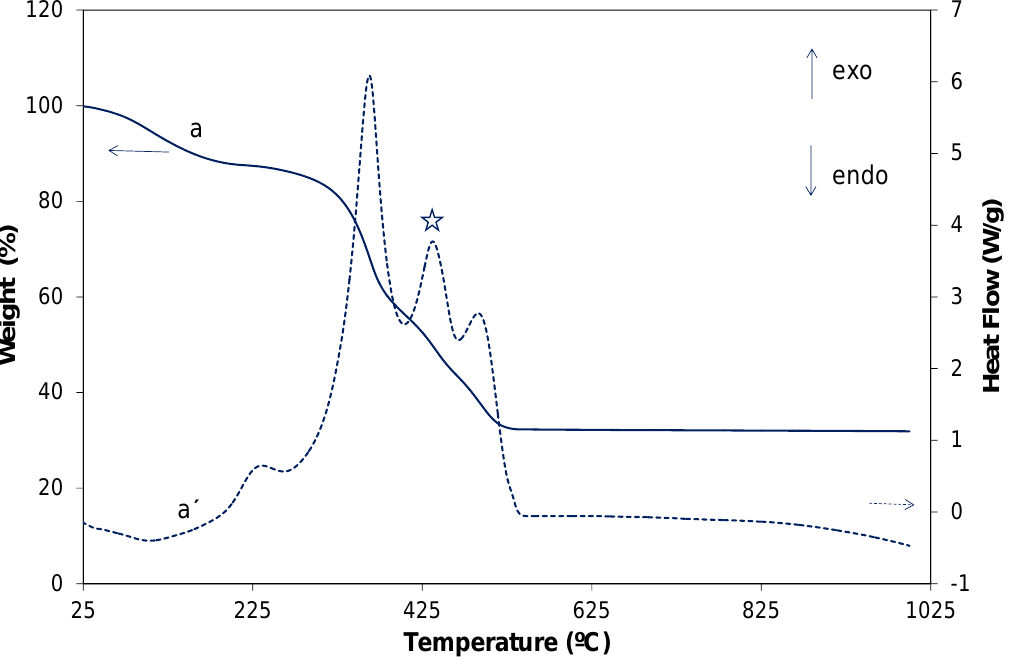
Figure 8. Thermogravimetric and differential thermal analyses curves of the Ti 0.988 Tb 0.012 [(OH) 4 − u Cl v ]@PST – PDVB composite (a and a ′ , respectively) in air (Tb content is 0.12 at.%). The star indicates the exothermic peak related to Cl − removal.